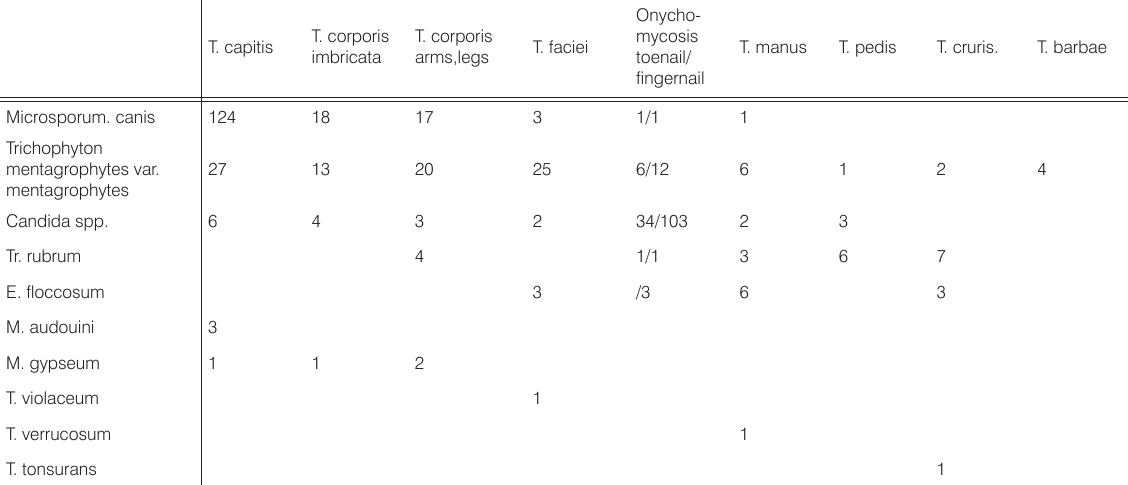
Table 3 Number of positive dermatophytes and Candida findings by location of infection